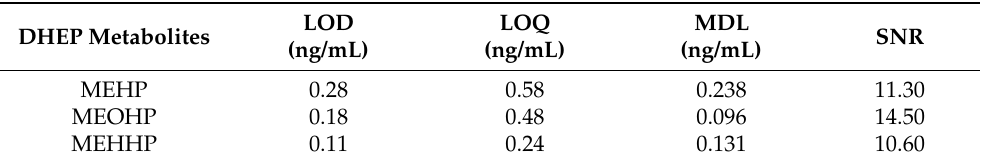
Table 4. Limit of Detection (LOD), Quantification (LOQ), and Method Detection Limit (MDL); SNR: signal-to-noise ratio.